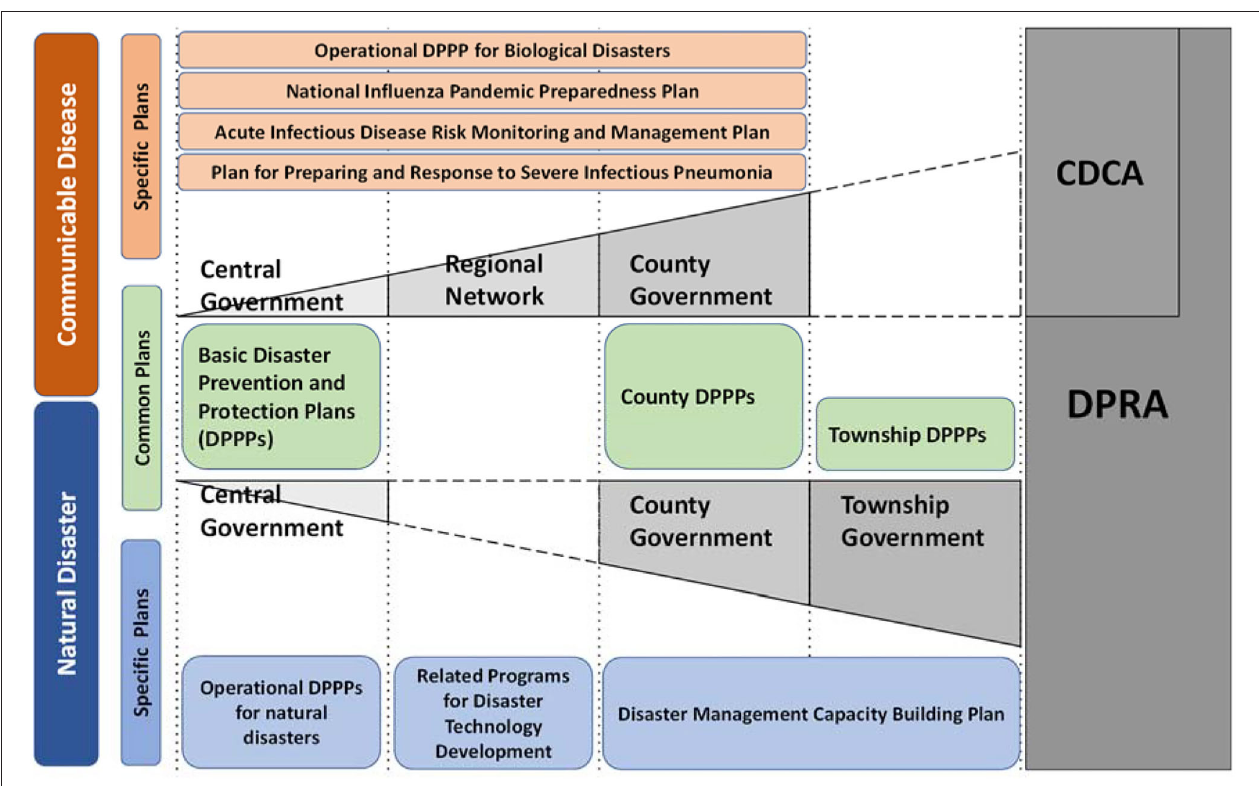
FIGURE 4 | The laws and plans for natural disasters and communicable